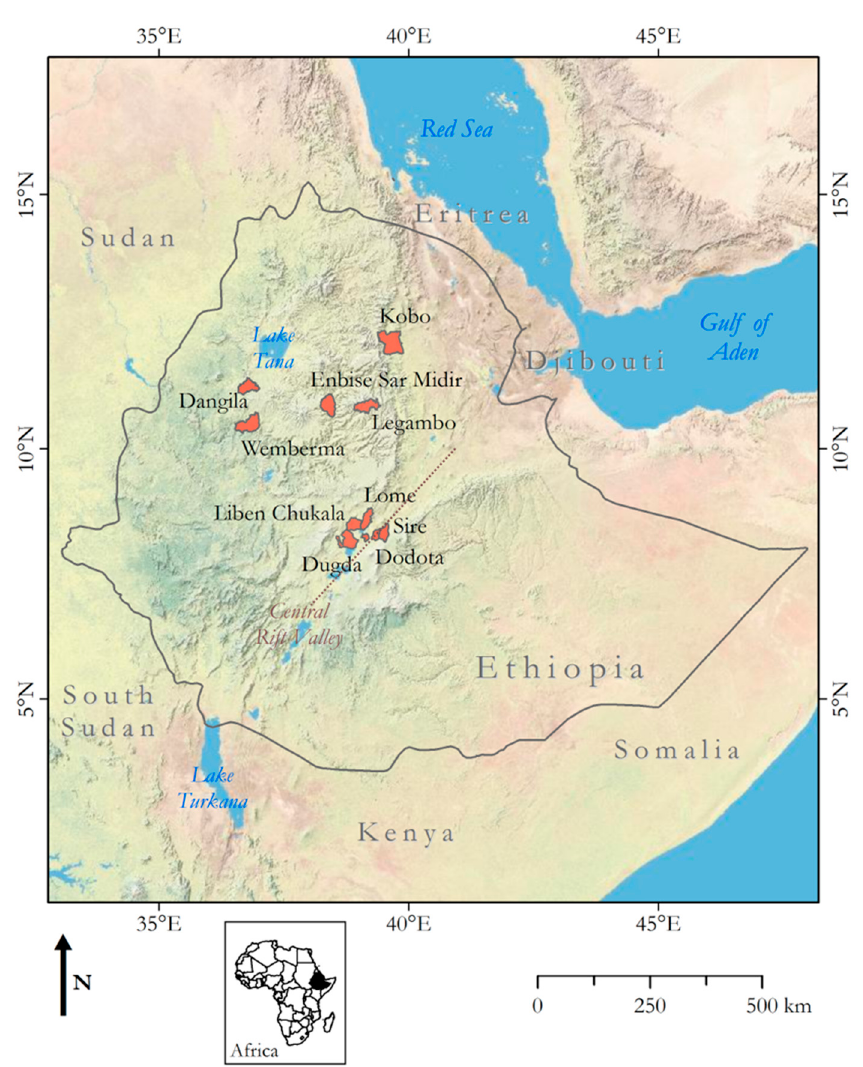
Figure 1. Ten woredas (sub-districts) in the Amhara Highlands (around Lake Tana) and Central Oromia region (adjacent to the Central Rift Valley) over which boundary mapping methods were evaluated using WorldView 2 and 3 imagery taken from 2009–2016.